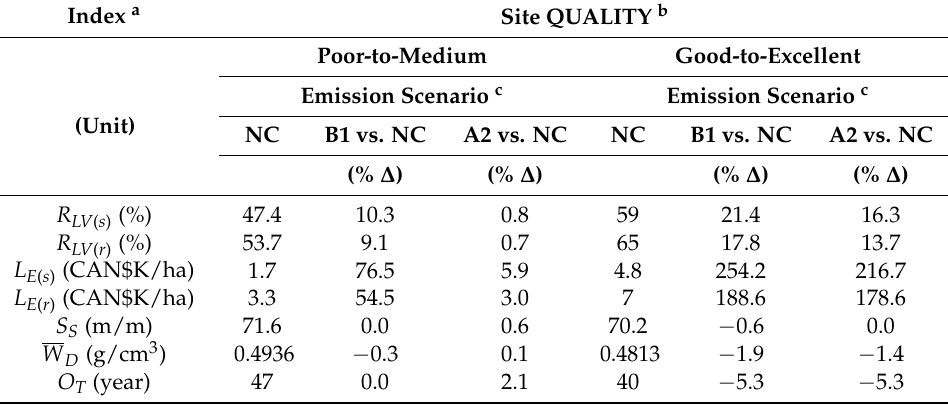
a–c : As defined in Table 3a table notes. Table 3c. Stand-level performance indices for black spruce plantations managed under a basic silvicultural intensity in north-western Ontario by emission scenario and site quality.